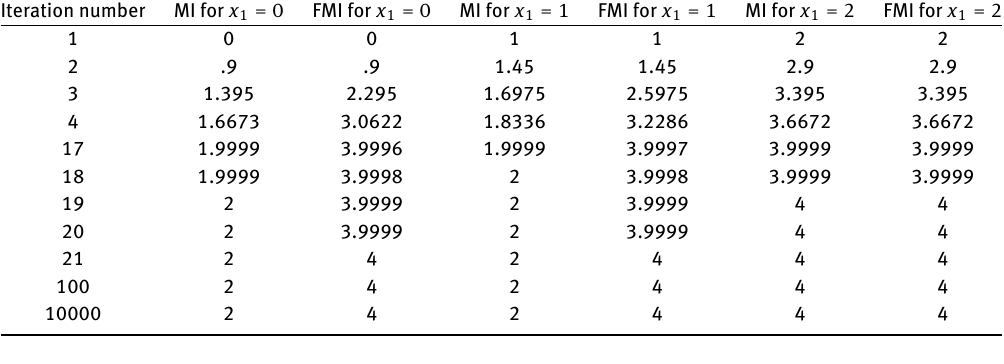
Table 2: Convergence table of Mann iteration and Fibonacci-Mann iteration for t n = .55 . Iteration